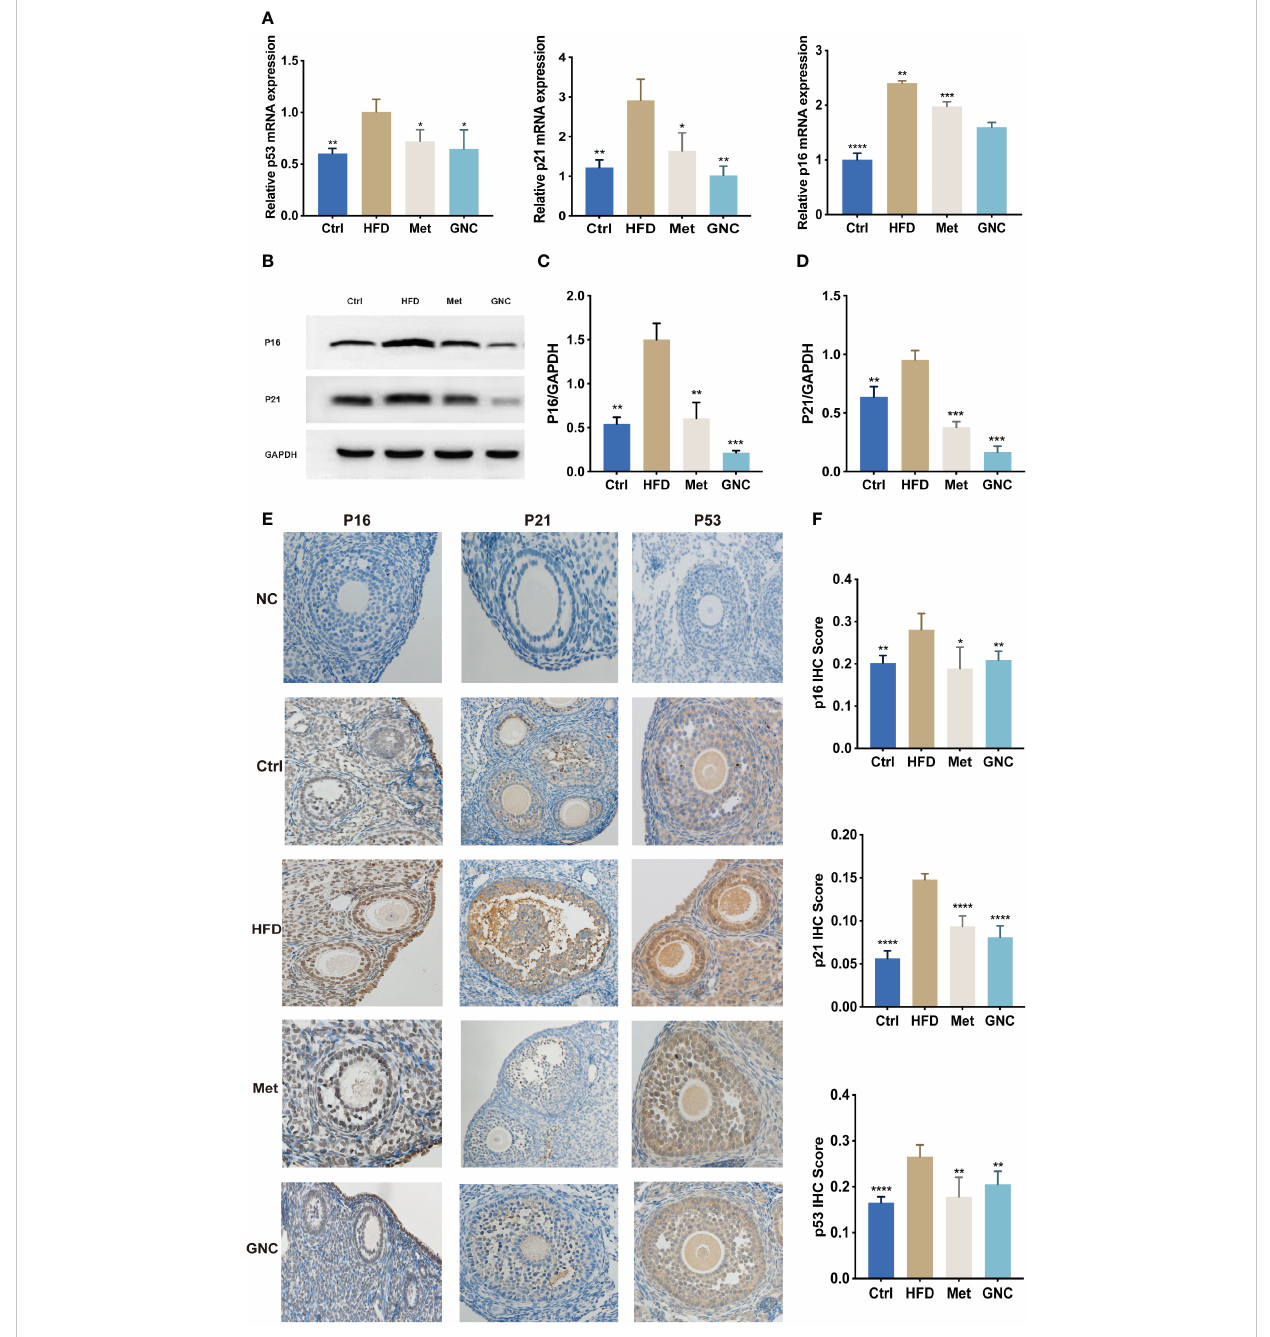
FIGURE 8 Gengnianchun reduced aging-related mRNA and protein levels. (A) The relative mRNA expression of P53, P16 , and P21 in ovaries of mice in each group were detected by qPCR. n=3; t-test. (B – D) The protein expression of P53, P16 , and P21 in the ovaries of mice in each group. n=3; t-test. (E, F) The protein expression of p16, p53 , and p21 in Ctrl (n = 5) and HFD (n = 5) mouse ovaries were determined by IHC. n=5; *: P<0.05, **: P<0.01, ***: P<0.001, ****: